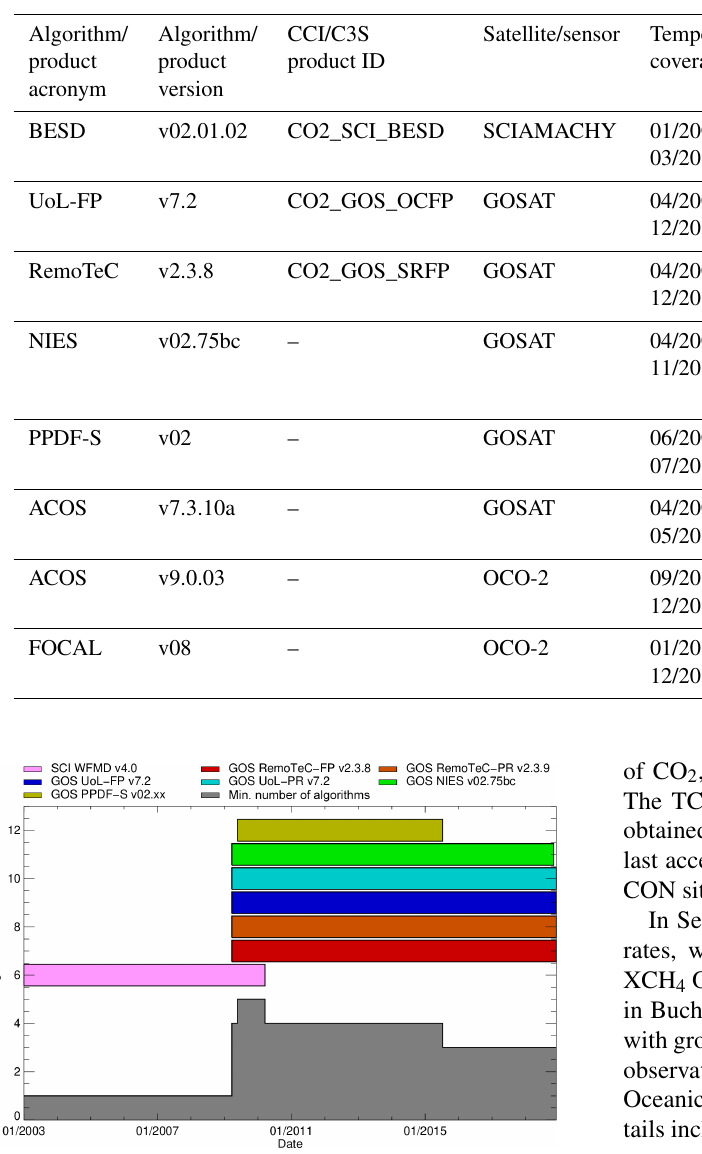
Figure 4. As Fig. 3 but XCH 4 . For details on each product see Ta- ble